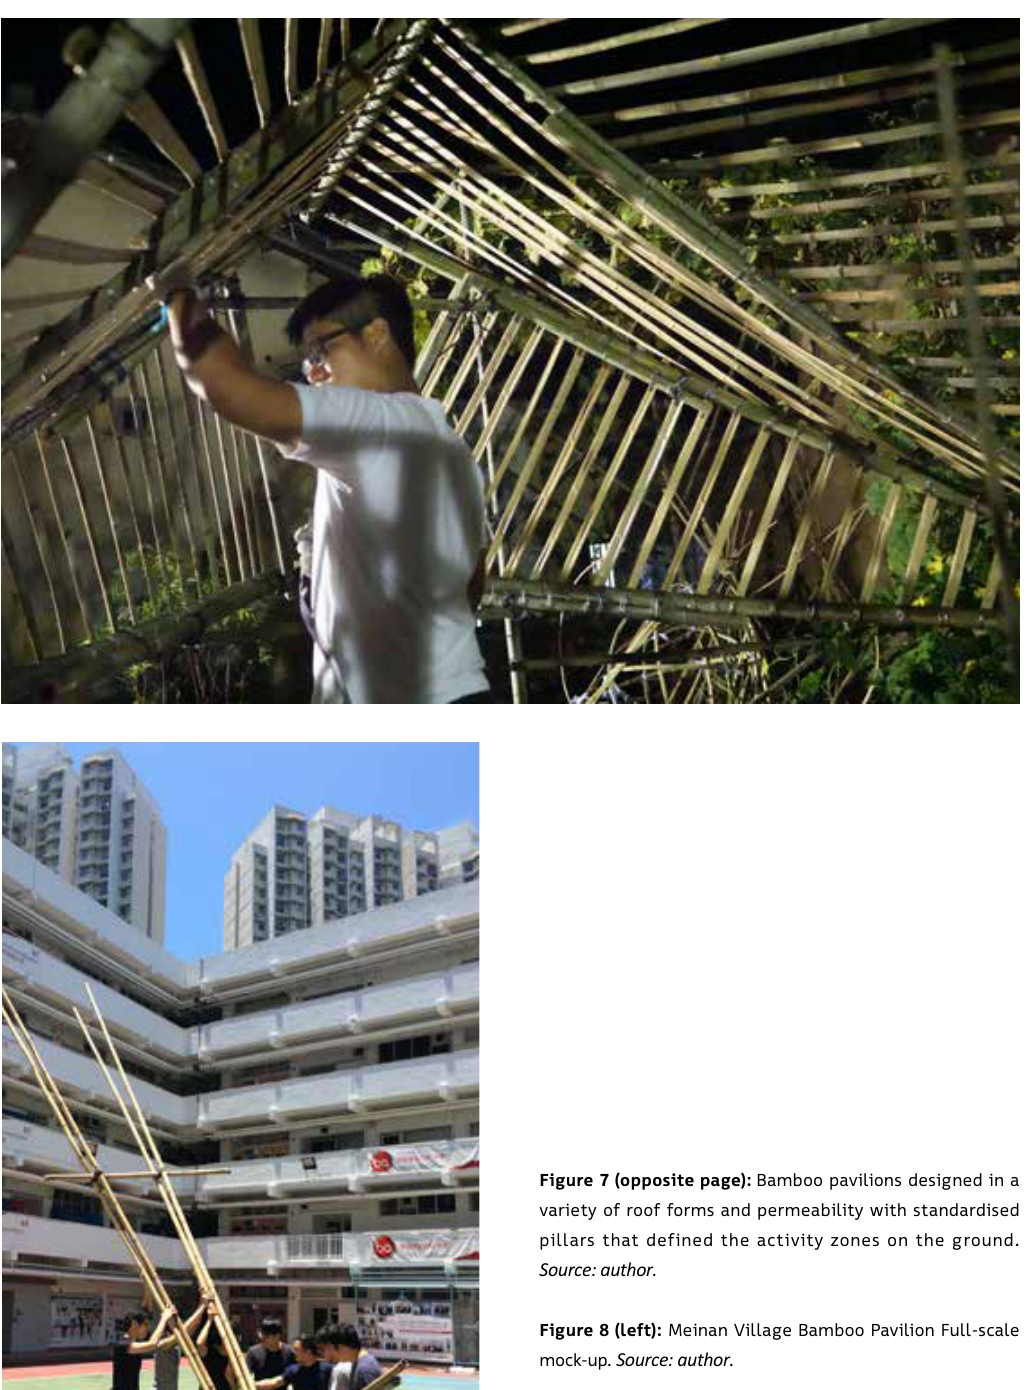
Figure 7 (opposite page): Bamboo pavilions designed in a variety of roof forms and permeability with standardised pillars that defined the activity zones on the ground. Source: author. Figure 8 (left): Meinan Village Bamboo Pavilion Full-scale mock-up . Source: author. Figure 9 (top): Continuous testing and modification of the shading screen during construction. Source: author. Figure 10 (page 180): In the Meinan Village Bamboo Pavilion human activity is an intuitive response to the environment. Spatial understanding becomes experiential through activity. Source: